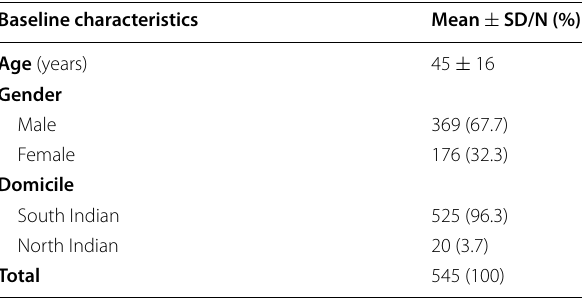
Table 1 Summary of demographic data of the study population Baseline characteristics